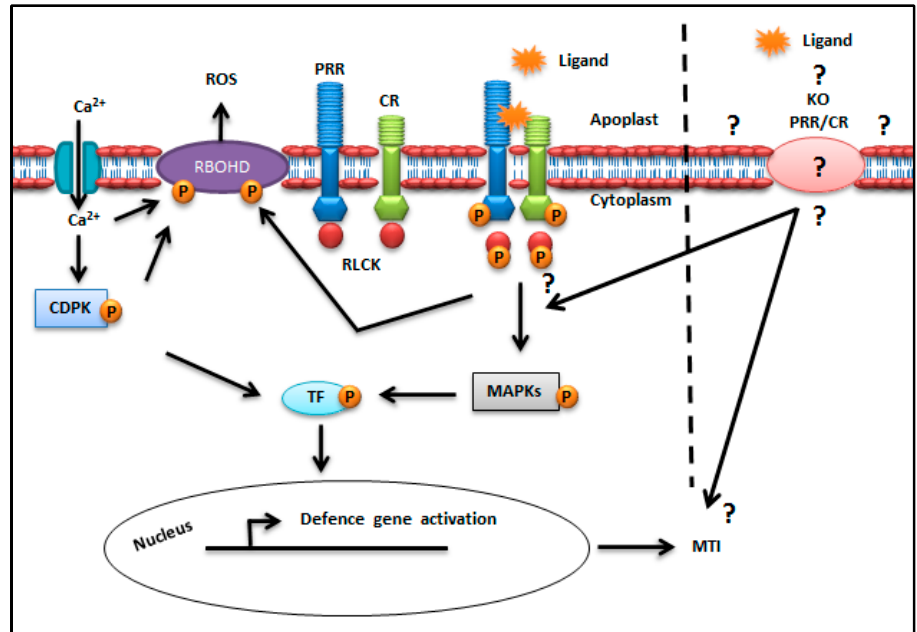
Figure 1. Generalised view of MAMP perception via PRRs, illustrating the potential impact of knockout (KO) effects that influence MAMP-triggered immunity. Upon MAMP (e.g., flg22) perception by a cognate PRR (e.g., in the case of FLS2 [28], the RLCK botrytis induced kinase1 (BIK1) dissociates from its complex with FLS2 and co-receptor BAK1. This leads to the activation of defence responses, such as ROS production, cytoplasmic Ca 2+ influx, activation of downstream signalling kinases (MAPK and CDPK) and upregulation of defence genes. KO of the PRR and/or co-receptor (demarcated by the dotted line) may impair activation of downstream defence signalling, that could possibly lead to increased susceptibility of a plant to a pathogen. P = Phosphorylation, RBOHD = Respiratory burst oxidase homolog D, TF = Transcription factor, PRR = Pattern recognition receptor, CR = Co-receptor, MAMP = Microbe-associated molecular pattern, ROS = Reactive oxygen species, CDPK = Calcium-dependent protein kinase, MAPK = Mitogen-activated protein kinase, RLCK = Receptor-like cytoplasmic kinase, MTI = MAMP-triggered immunity.